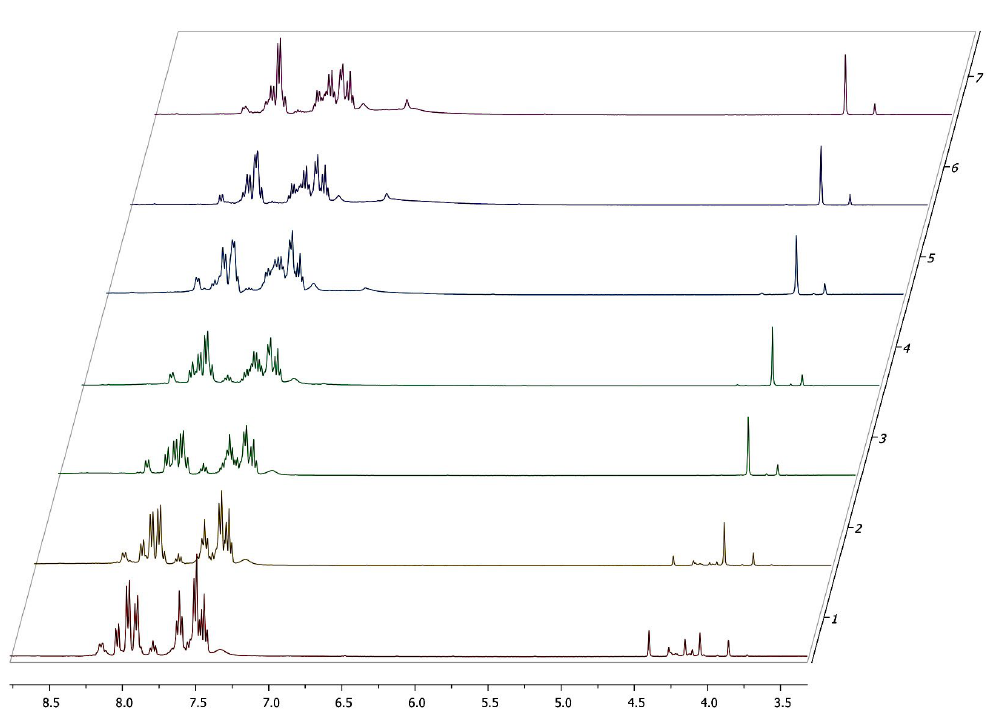
Figure 3. 1 H NMR monitoring of the progress of the reaction with time at 30 minute